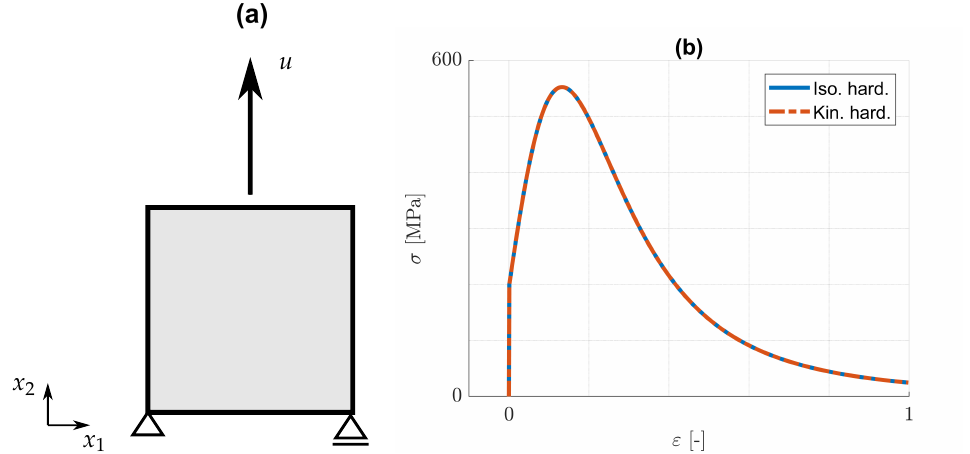
Figure 1. ( a ) One-dimensional model. Eight-node element subjected to tension/compression loading along the x 2 -axis. ( b ) Identical ( ε , σ ) -distributions due to pure isotropic and pure kinematic hardening for monotonic loading conditions.